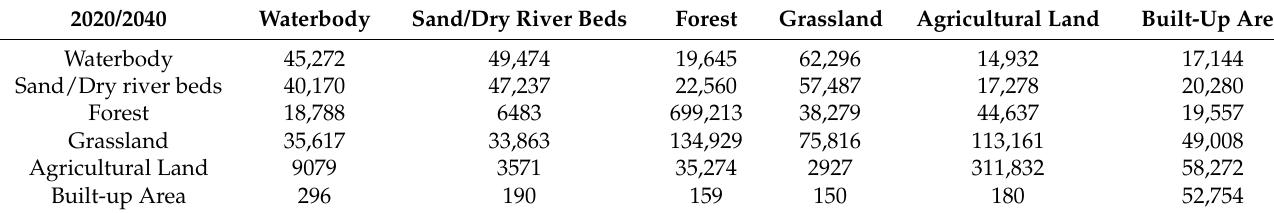
Table 9. Expected transition in 2040 by number of pixels.